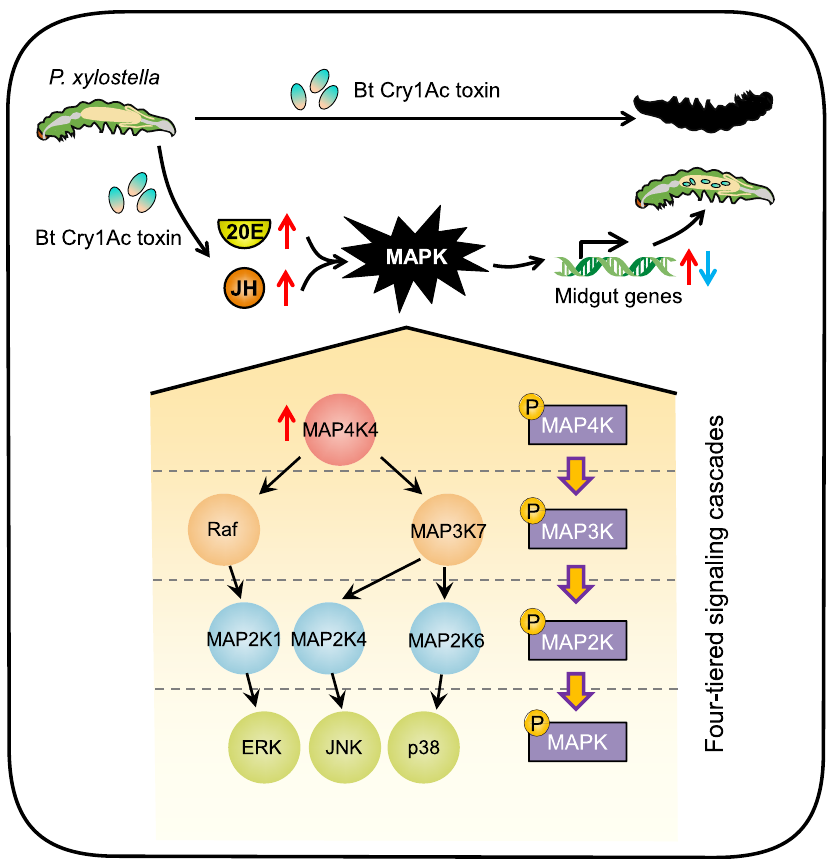
Fig 5. Schematic representation of the MAPK “road map” for overcoming Bt toxin action in P . xylostella . Upon exposure to Bt Cry1Ac toxin, susceptible P . xylostella larvae are killed, whereas with low doses, or in resistant larvae, increased levels of insect hormones (20E and JH) can activate the MAPK signaling cascades to regulate differential expression of multiple midgut genes resulting in larval survival [30,32].For the road map of MAPK signaling cascades three degenerate, four-tiered, branched signaling pathways, including MAP4K4-Raf-MAP2K1-ERK, MAP4K4-MAP3K7-MAP2K4-JNK and MAP4K4-MAP3K7-MAP2K6-p38, form the modules that regulate this